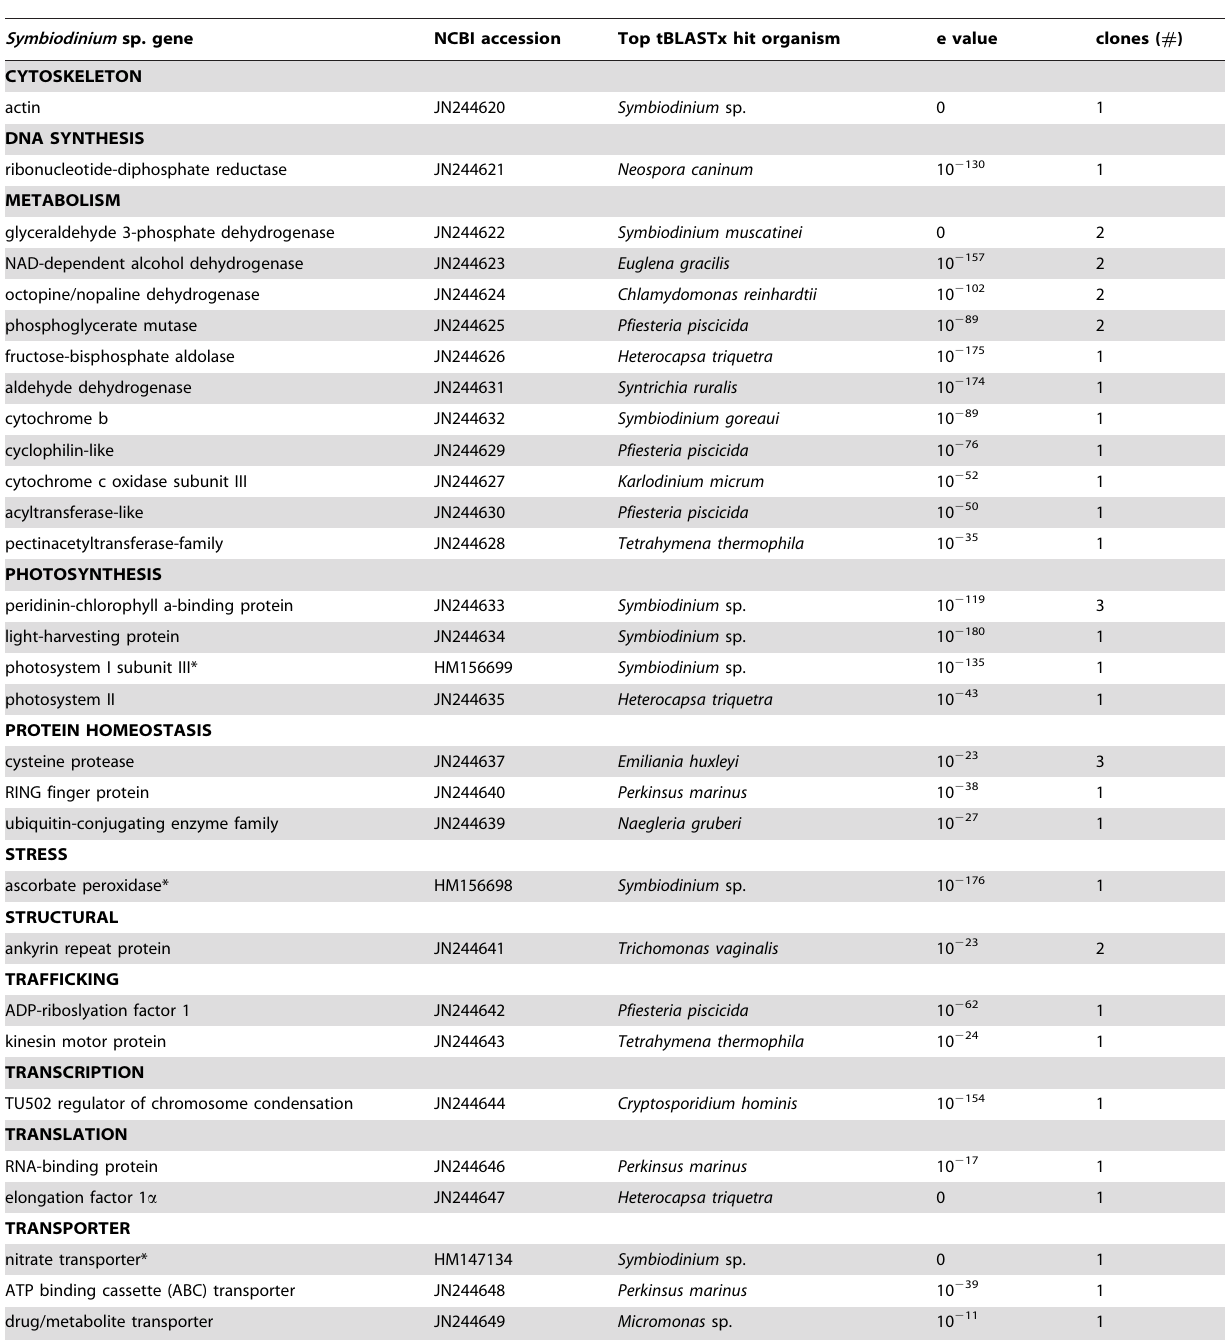
Table 1. Symbiodinium cDNA clones representing a diversity of functional categories.